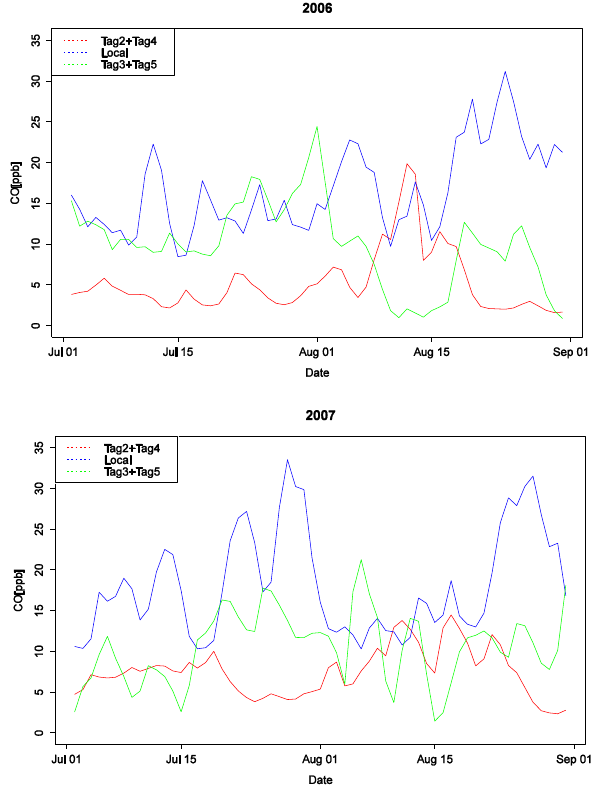
Fig. 16. The contribution of various sources to local concentration during July–August 2006 (upper panel) and 2007 (lower panel). Figure 16. The contribution of various sources to local concentration during July-August 2006 (upper panel) and 2007 (lower panel).